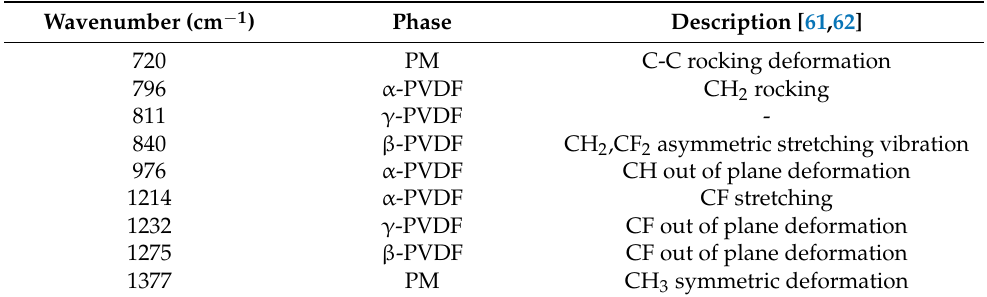
Table 3. Values and description of the main FTIR bands for α , β , γ -phases for PVDF and